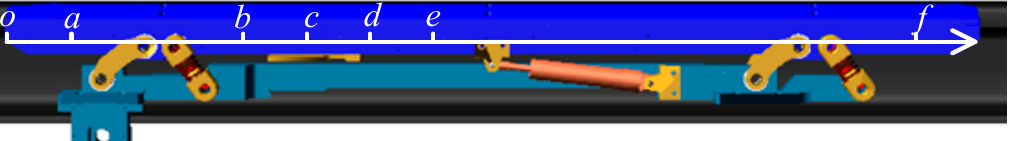
Figure 7. The motion states of the measuring ruler with different damping coefficients.